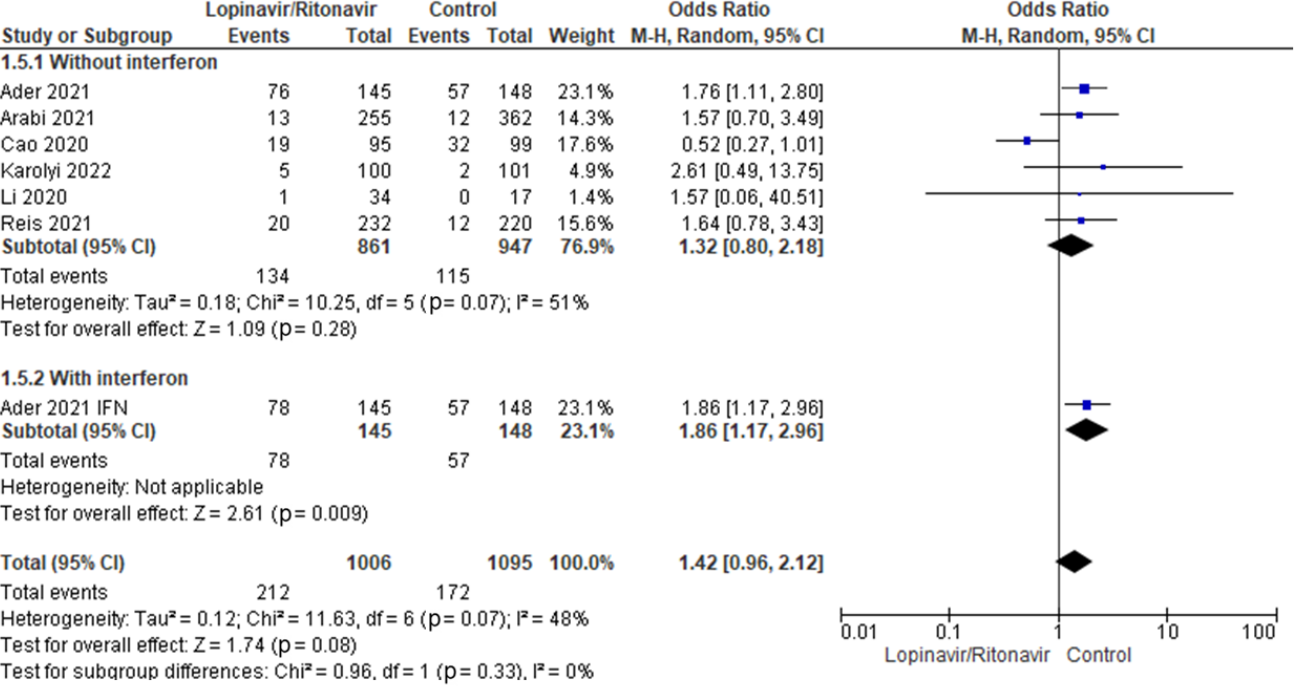
Figure 10. Subgroup analysis of serious adverse events. The sizes of the blue squares reflect the relative weight of the individual trials. The combined point estimates are shown as black diamonds. The diamonds and squares (together with the 95% CIs) located beyond the vertical line (indicating the unit value) show that a result was statistically significant.